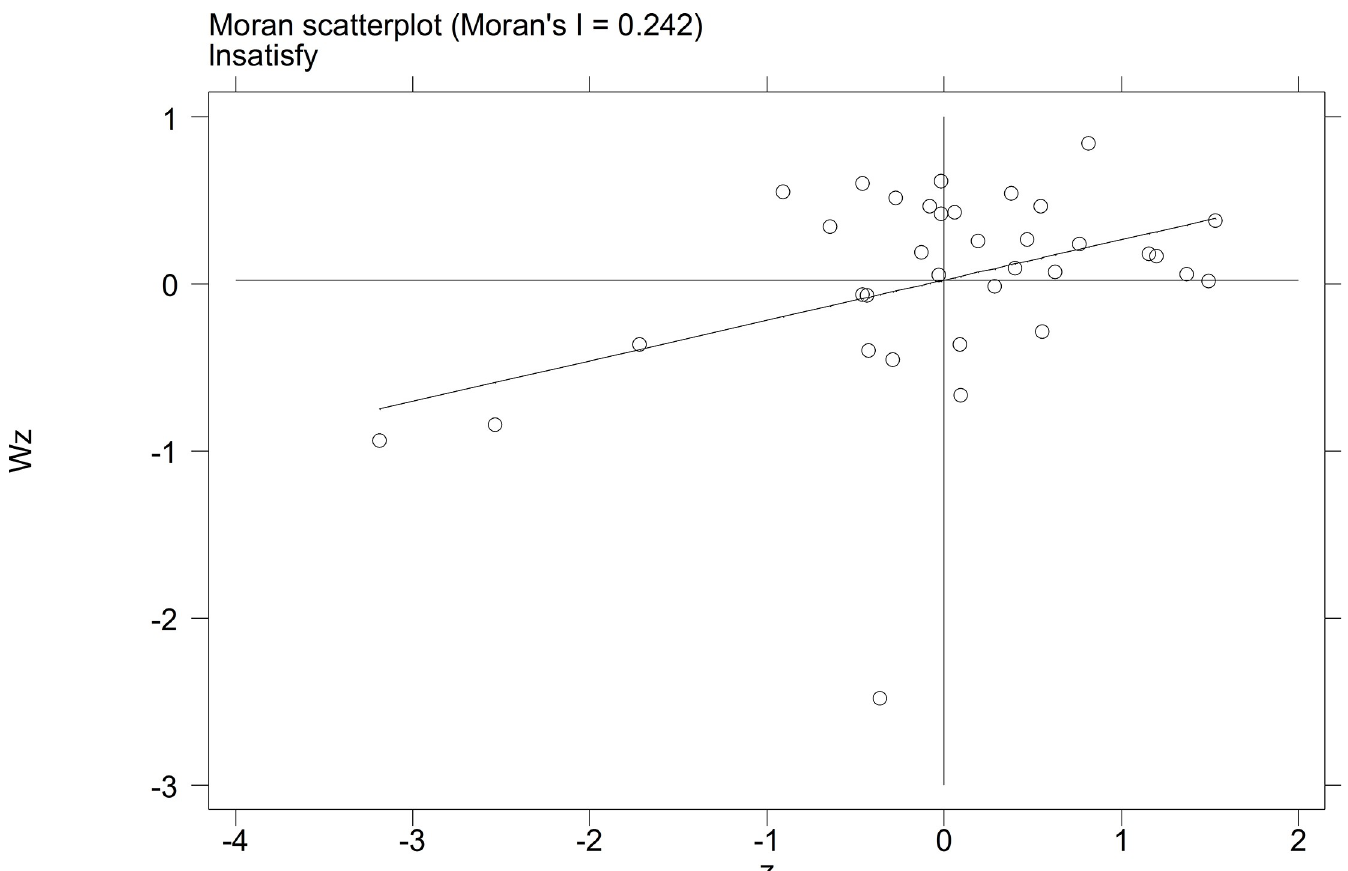
Fig 4. Scatterplot of Moran’ I for tourist satisfaction in Dec.